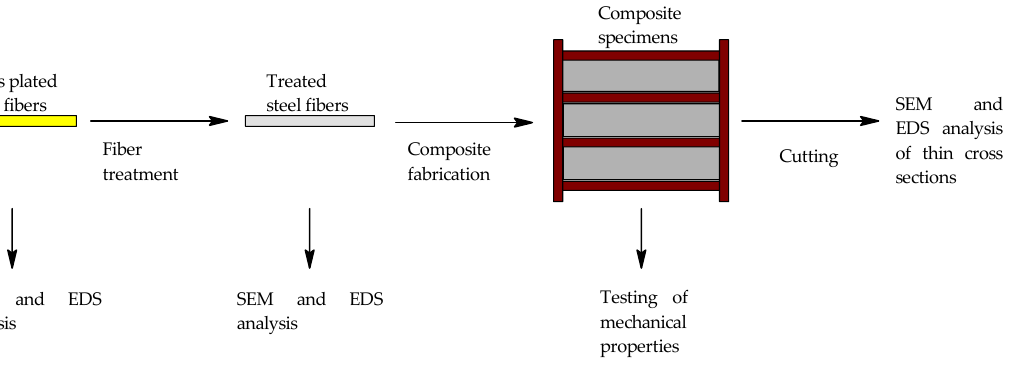
Figure 1. Whole experimental